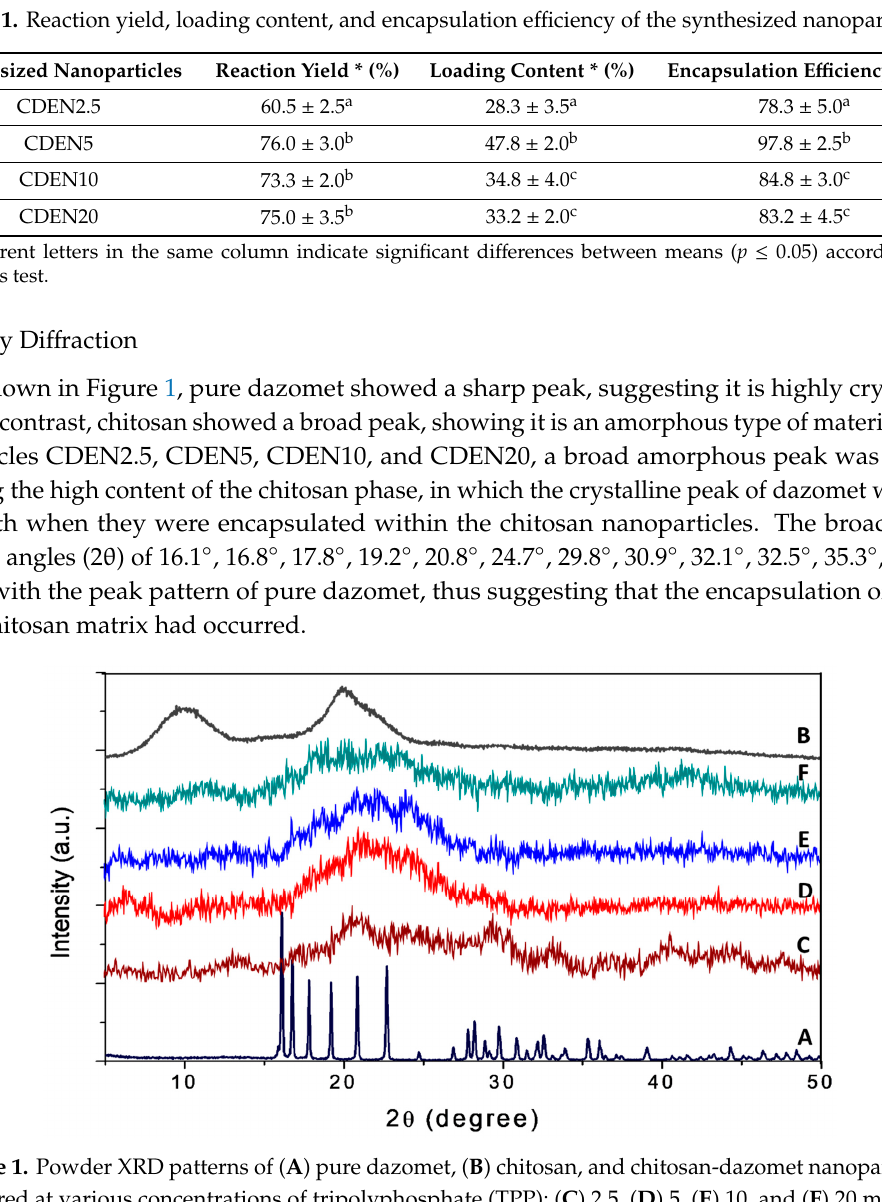
Table 1. Reaction yield, loading content, and encapsulation e ffi ciency of the synthesized nanoparticles. Synthesized Nanoparticles